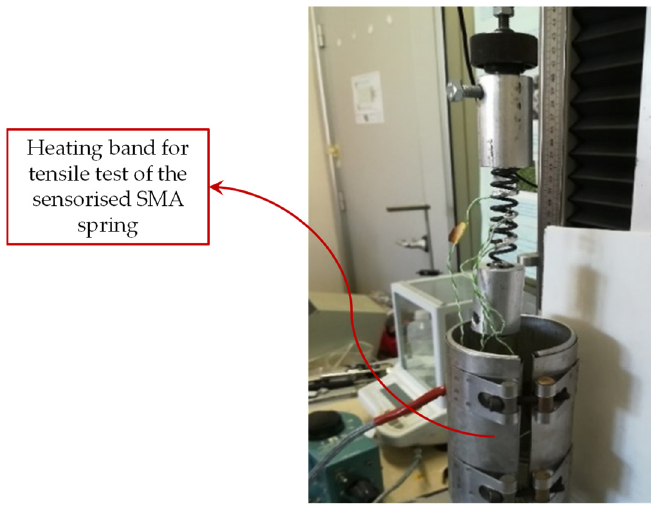
Table 3. Specific material values for martensite.